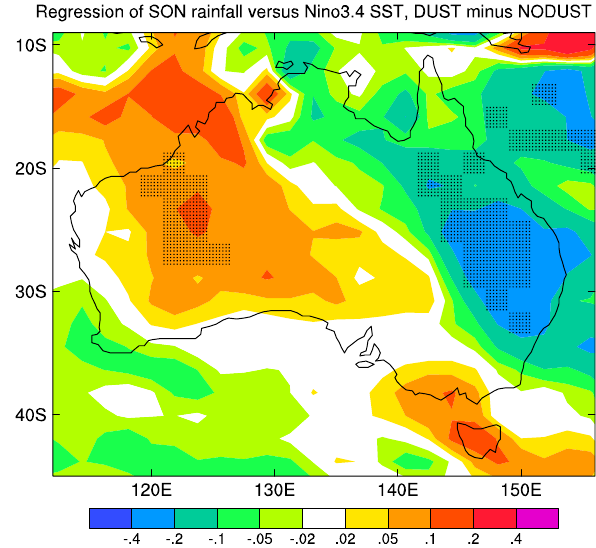
Fig. 6. Difference of the Ni˜no3.4 SST – rainfall regression slopes between the DUST and NODUST runs for SON. Stippled regions are significant at 5%.